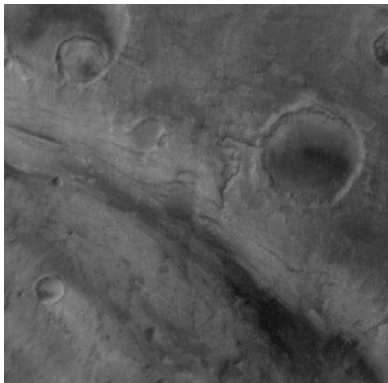
Figure 20. Area of study in the visible range [82].